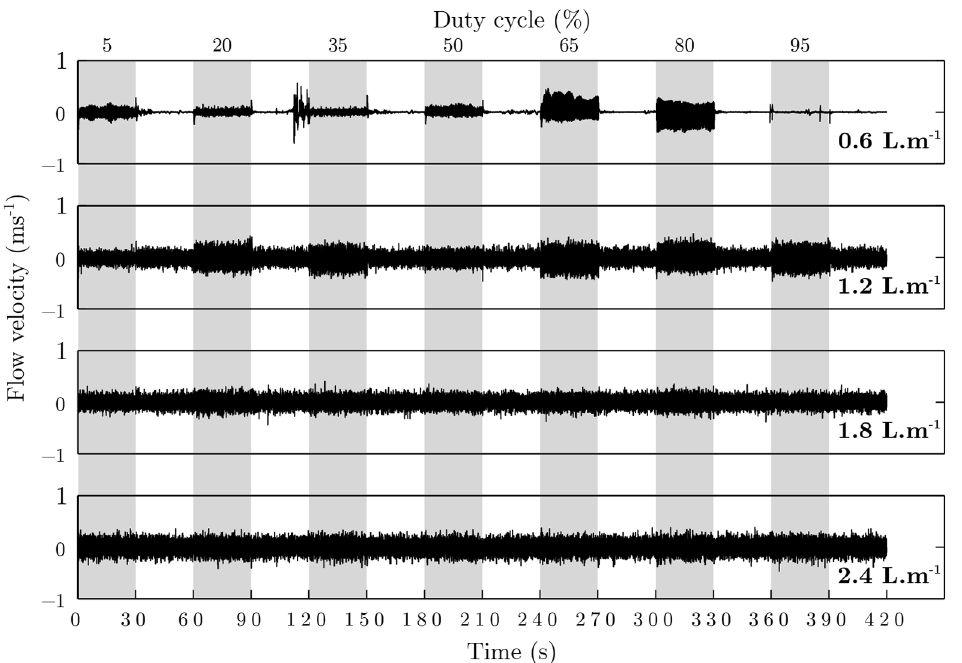
Fig 7. Flow velocity study. Measure of flow velocity during a stimulation (gray) and rest with airflow of 0.6, 1.2, 1.8 and 2.4 L.min − 1 and with seven values of a duty cycle from 5 to 95% with step of 15%.